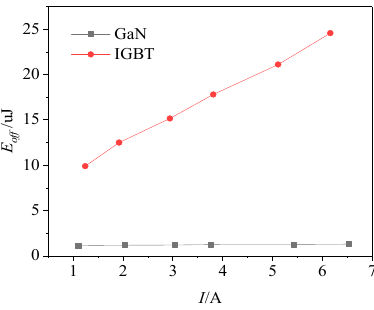
Figure 12. GaN and IGBT Turn-off Loss.